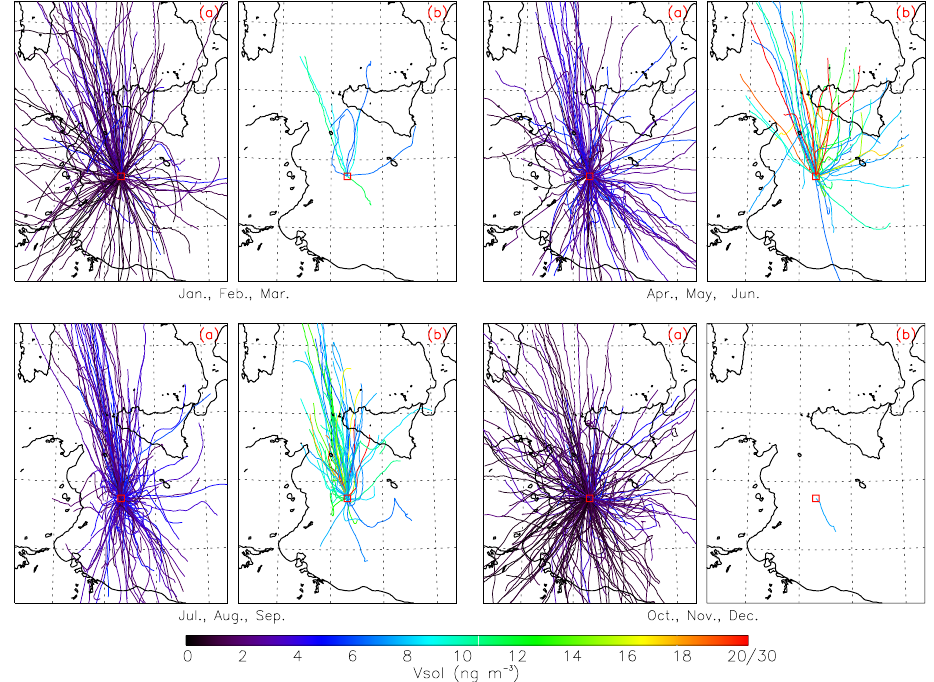
Fig. 5. Panels (a) and (b) show the 18h back trajectory relatives to the measurements of V sol less than or great/equal to 6ngm − 3 (i.e. V st ) respectively. The trajectories are grouped in quarters, each one representing three months. Table 2. For the two periods having different resolution time (June 2004 and August 2007) are reported: the number of PM samples (measure- ments of V sol ), the number (frequency occurrence on the total number of annual V sol measurements) of measurements with V sol > 6ngm − 3 , the mean and standard deviation values. The number of episodes of single and consecutive days (frequency occurrence on the number of annual V sol measurements affected by ship emission) of V sol > 6ngm − 3 , the correspondent periods mean and standard deviation values of the single and multiple day episodes are also